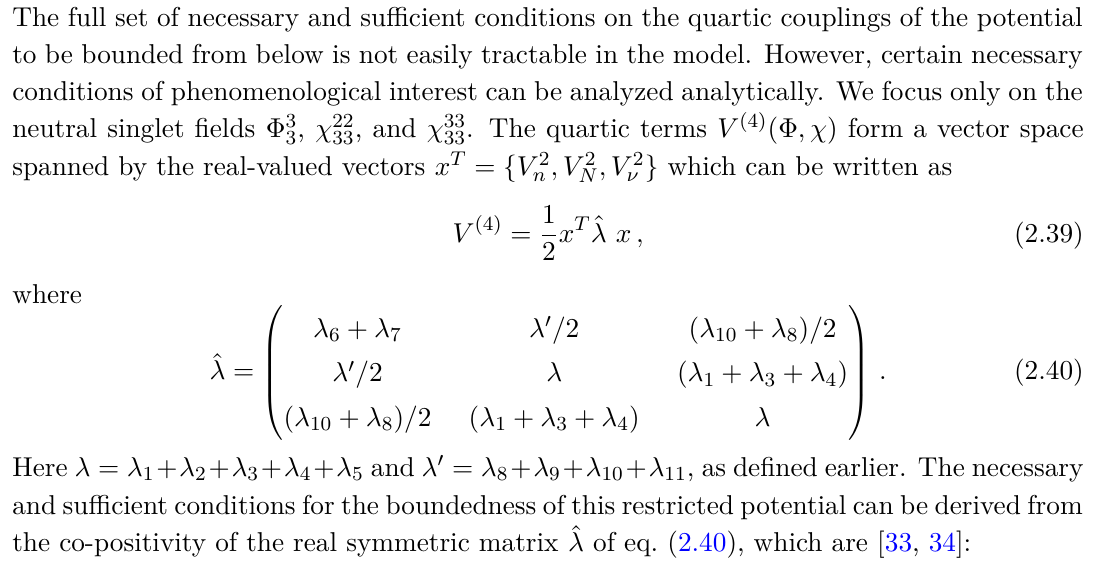
= 0 . 65 (0 . 39) for h